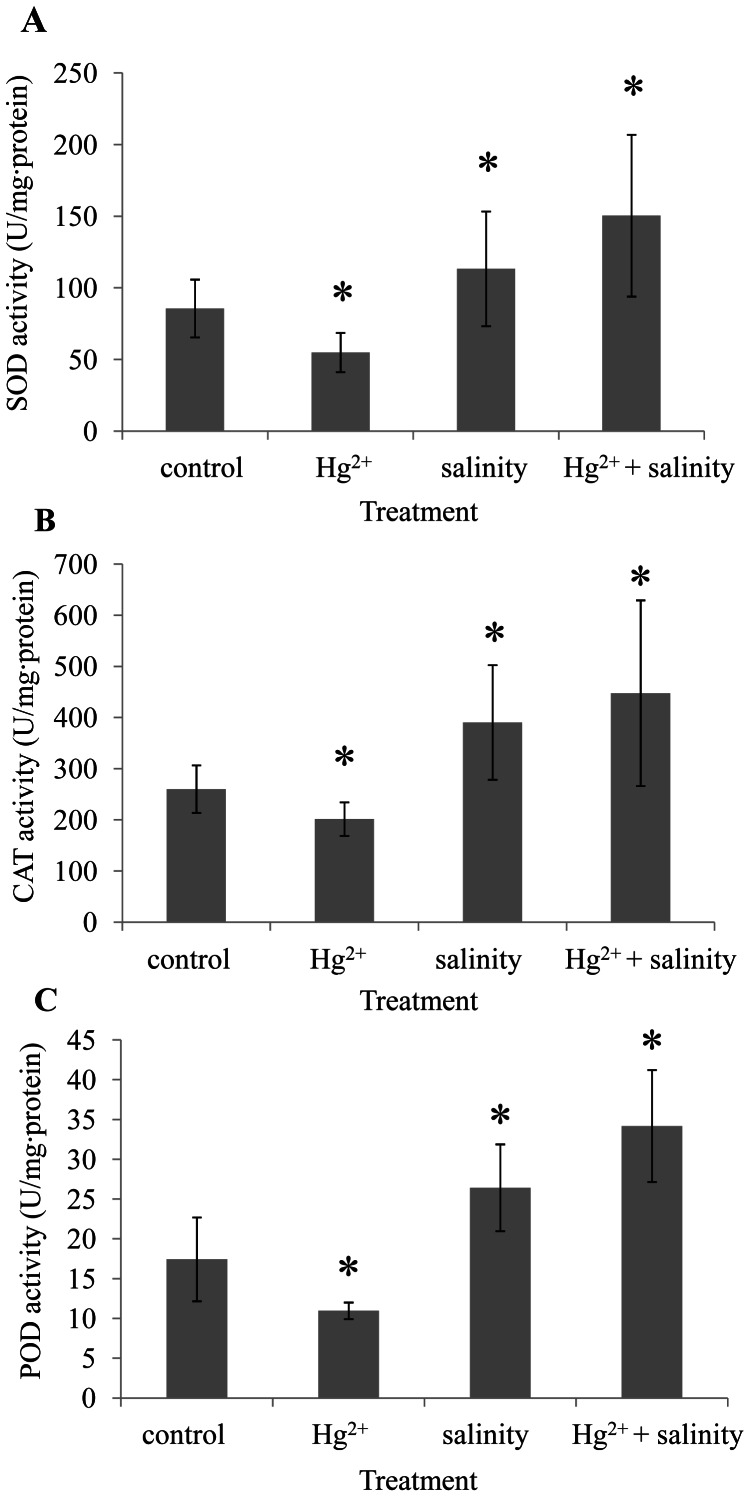
The activities (U mg−1 protein) of SOD (A), POD (B) and CAT (C) in leaf tissues from control, Hg2+ (20 µg L−1), salinity (NaCl, 500) and Hg2++salinity-exposed S.
salsa samples (n = 6).Data were expressed as mean ± standard deviation. Significant difference between control and exposed groups was tested by one-way analysis of variance with Tukey’s test and indicated by *(P<0.05) and **(P<0.01).